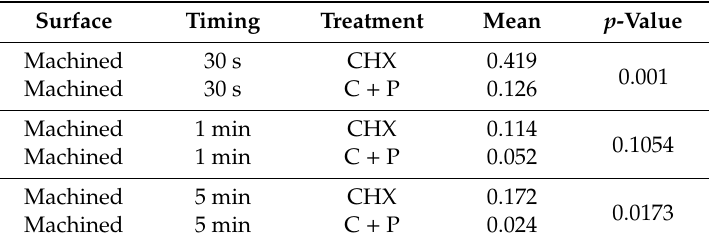
Table 2. Comparative table for smooth surfaces.